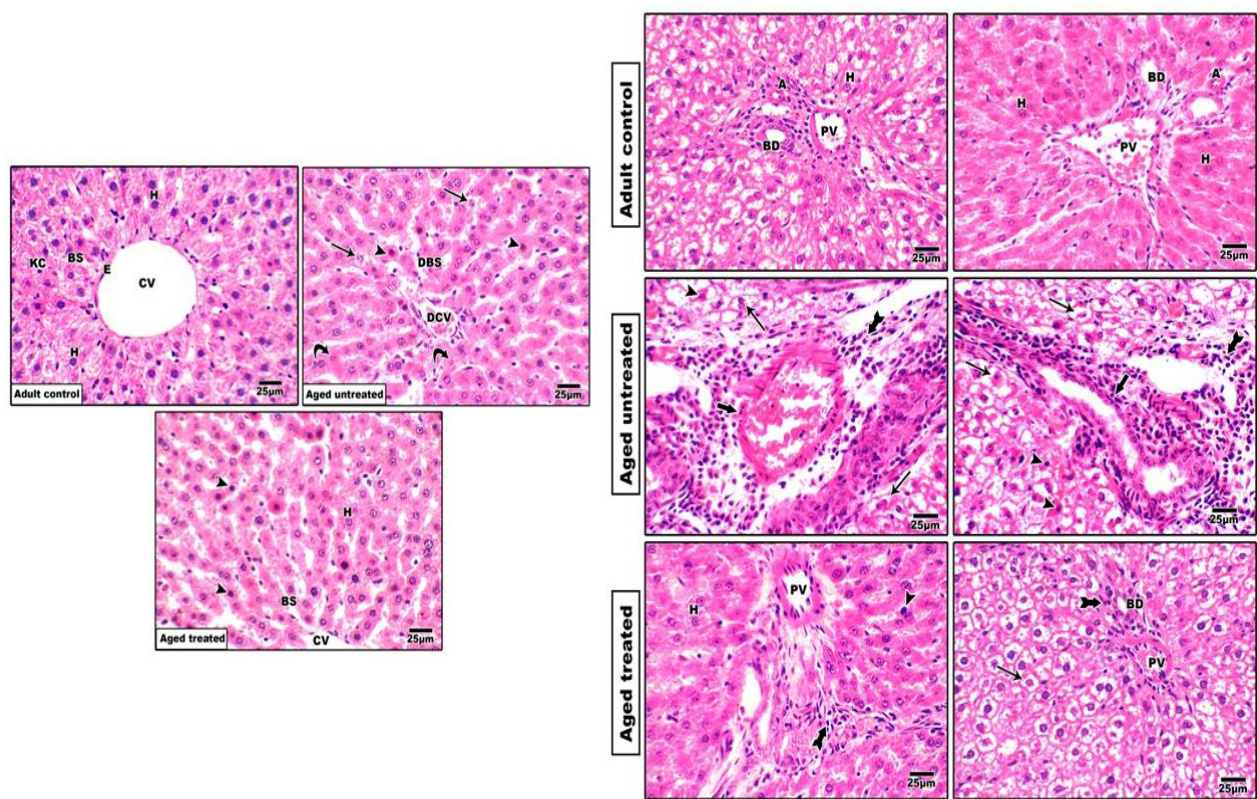
Figure 2. Left panel showing central vein: Adult control group showing hepatocyte cords radiating from the central vein with acidophilic cytoplasm and rounded nuclei. Aged untreated group showing an irregular arrangement of hepatocytes with vacuolated cytoplasm. Some cells show apoptotic changes with dark small nuclei. Aged-treated group showing hepatocyte-arranged cords with fewer apoptotic cells. H: hepatocytes, Head arrows: apoptotic bodies, CV: Central vein, Arrows: degenerated hepatocytes, DBS: dilated blood sinusoids and DCV: dilated central vein. Right panel showing portal vein: Adult control group showing normal hepatocytes with acidophilic cytoplasm and rounded nuclei around the portal tract composed of the portal vein, hepatic artery and bile duct. Aged untreated group showing an irregular arrangement of hepatocytes with marked vacuolization and hydropic degeneration. Areas of piecemeal necrosis and increased portal inflammatory infiltrate are seen. Some cells show apoptotic changes with dark small nuclei. Neocholagioles and areas of focal lytic necrosis are present. Aged-treated aged group showing hepatocytes and portal tract with fewer apoptotic cells and inflammatory infiltrate. Reduced areas of lytic necrosis and a portal tract-preserved structure are also observed. H: normal hepatocytes, Arrows: degenerated hepatocytes, Head arrows: apoptotic cells, PV: portal vein, A: hepatic artery, BD: bile duct, bold arrow: inflammatory infiltrate and tailed arrows: focal lytic necrotic areas.